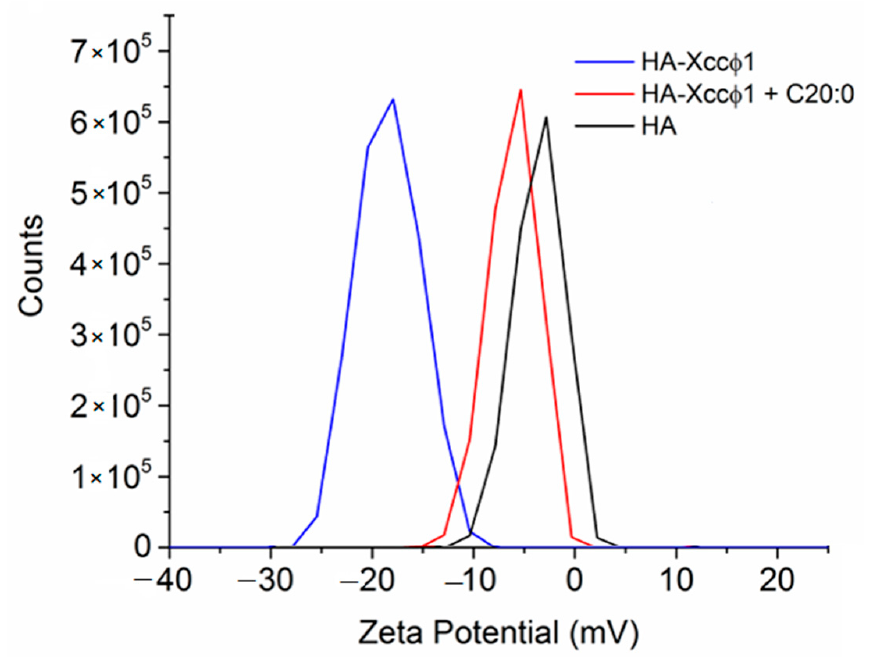
Figure 5. Zeta potential analysis of HA, HA-Xcc φ 1, and HA-Xcc φ 1+C20.